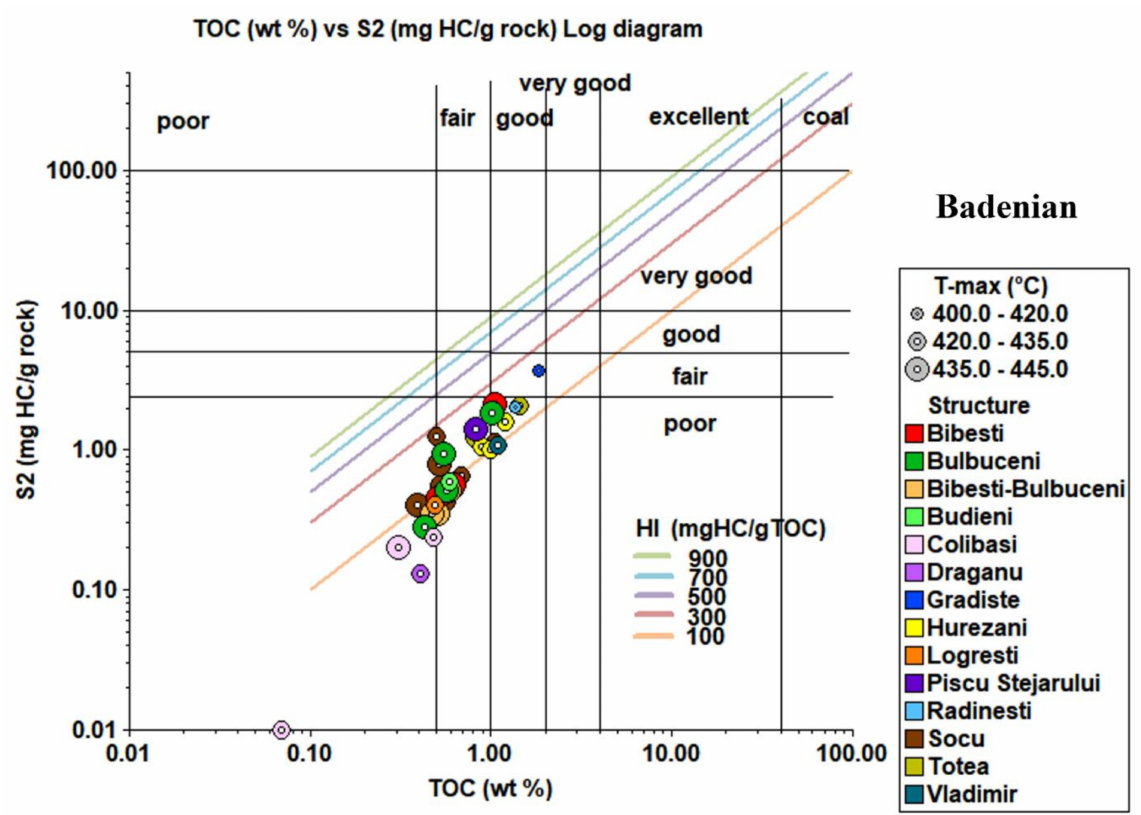
Figure 12. Hydrocarbon generation potential of Upper Badenian samples of the Getic Depression evaluated from TOC (wt.%) and S 2 (mg HC/g rock)